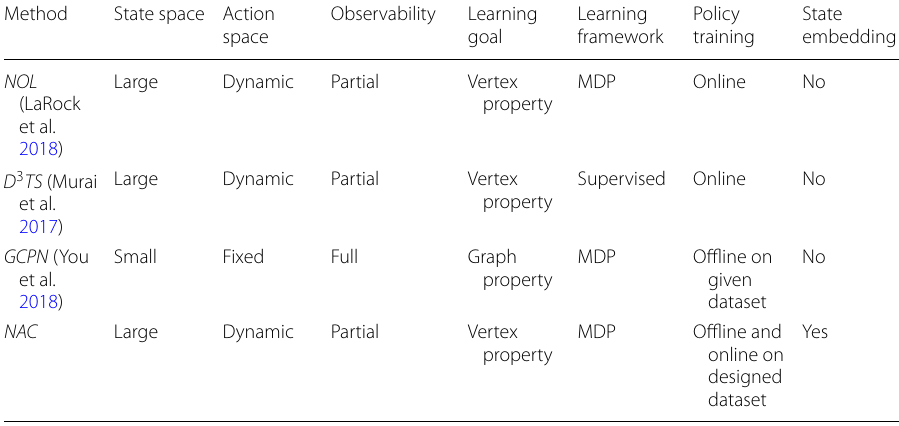
Table 1 Comparison of NAC features with related methods